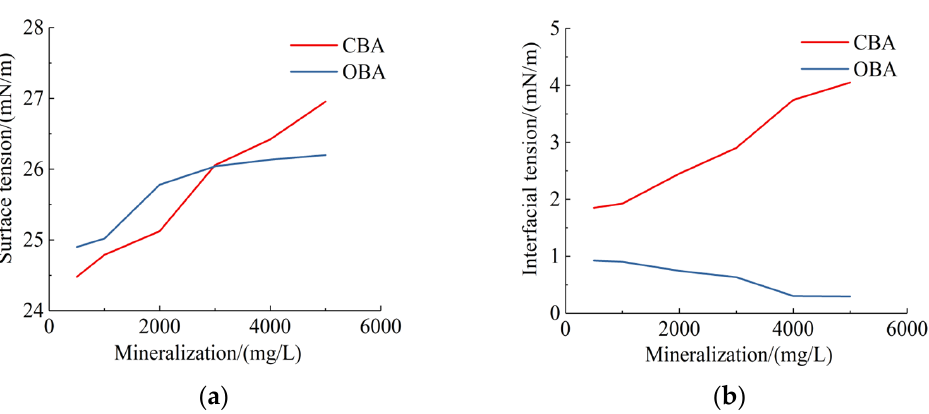
Figure 3. Effect of mineralization intensity on the surface/interfacial tension. ( a ) Surface tension; ( b ) interfacial tension.